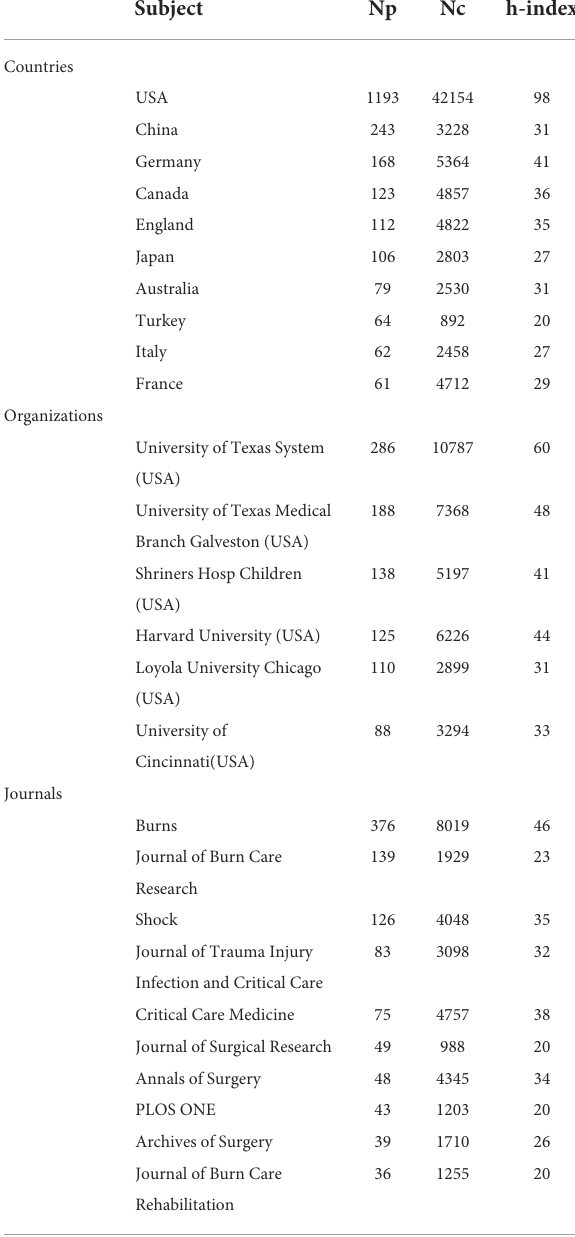
TABLE 2 Top ten